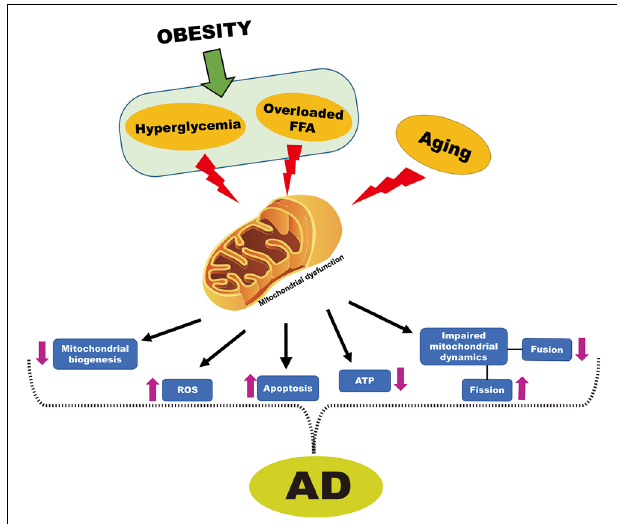
FIGURE 4 | Obesity-induced mitochondrial dysfunction cross-talk with AD. Hyperglycemia and overloaded FFA that are associated with obesity and aging are known to cause mitochondrial dysfunction. Dysfunctional mitochondria decreased mitochondrial biogenesis, increased ROS, increased apoptosis, reduced adenosine triphosphate (ATP) generation, impaired mitochondrial dynamics, which is characterized by increased fission and reduced fusion. All of these events are also associated with mitochondrial dysfunction in